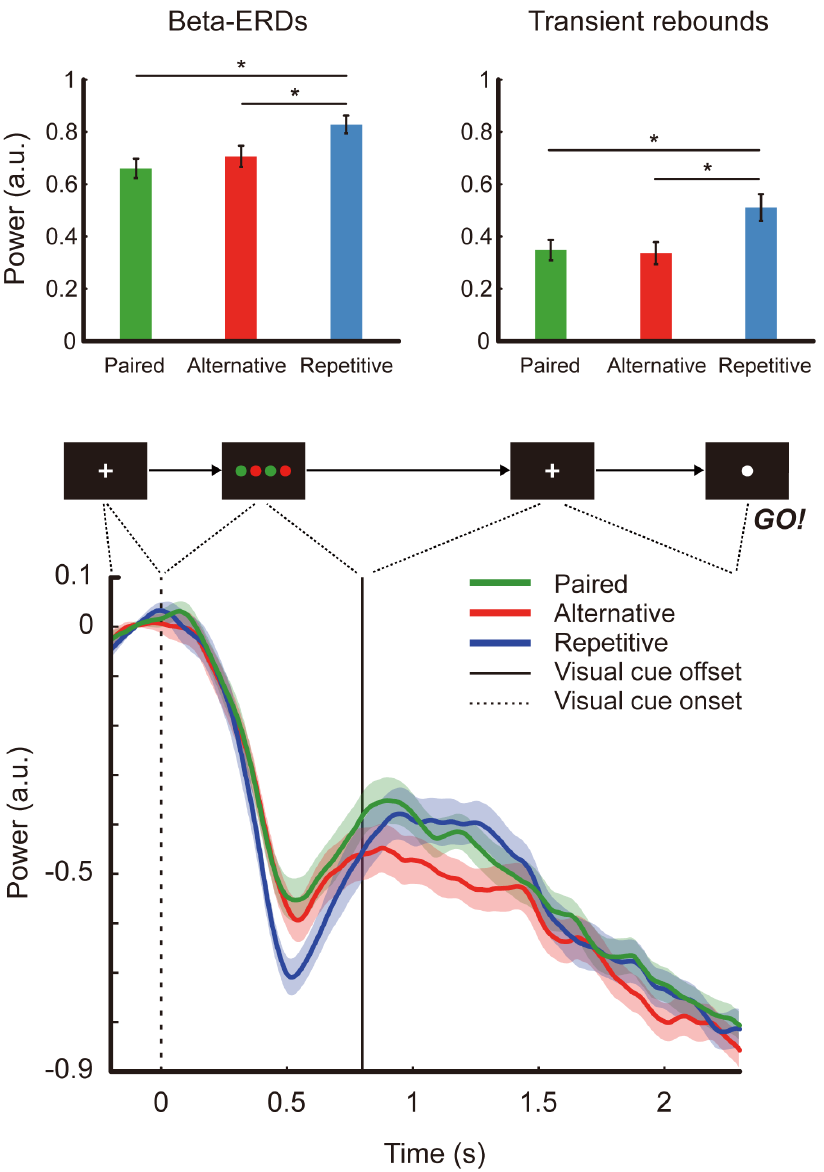
Figure 4. Result summary. Power differences for beta-ERD during visual cue display (upper left), and transient rebound following maximum ERD (upper right), and the averaged beta power time-courses for 21 subjects (bottom). The vertical axis is power in arbitrary units. Green line is ‘Paired’ red line is ‘Alternative’ and blue line is ‘Repetitive’. Asterisks show statistical significance at p , 0.05 by the linear mixed model. Error bars indicate standard